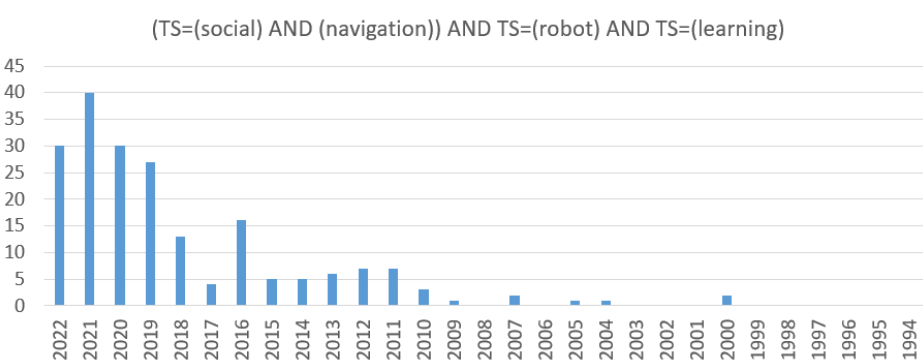
Figure 3. Web of Science Analyze filter: (TS = (social AND navigation)) AND TS = (robot) AND TS =